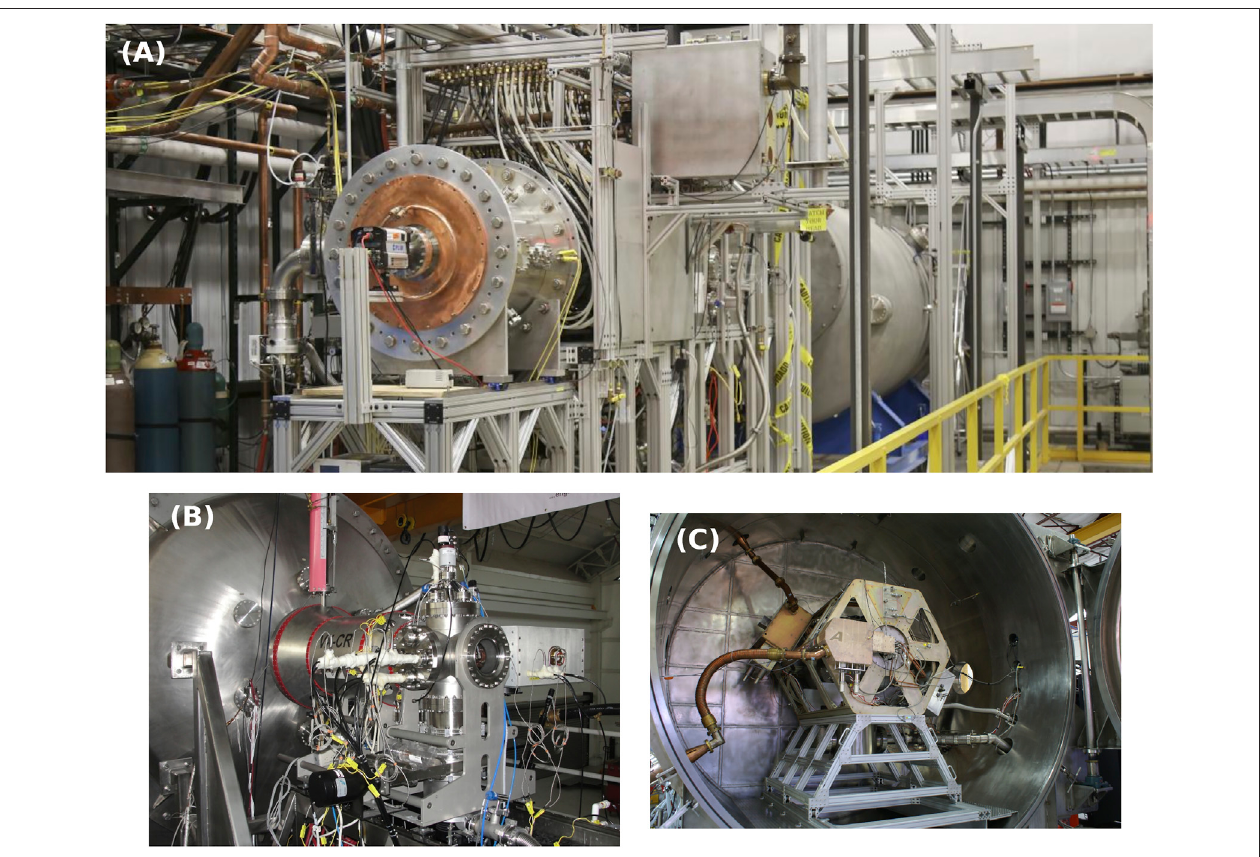
FIGURE1 | Examples ofapplicationsofHelicon Plasma Sources. (A) TheProto-MPEX linear devicefor the study ofplasma-material interactions at fusion-relevant conditions [3]. Courtesy of Oak Ridge National Laboratory, U.S. Dept. of Energy. (B) The VX-CR research helicon plasma source [61]. Courtesy of Ad Astra Rocket Company Costa Rica, Liberia, Costa Rica. (C) The VASIMR VX-200SS high-power propulsion engine [12]. Courtesy of Ad Astra Rocket Company, Webster, TX, United States.